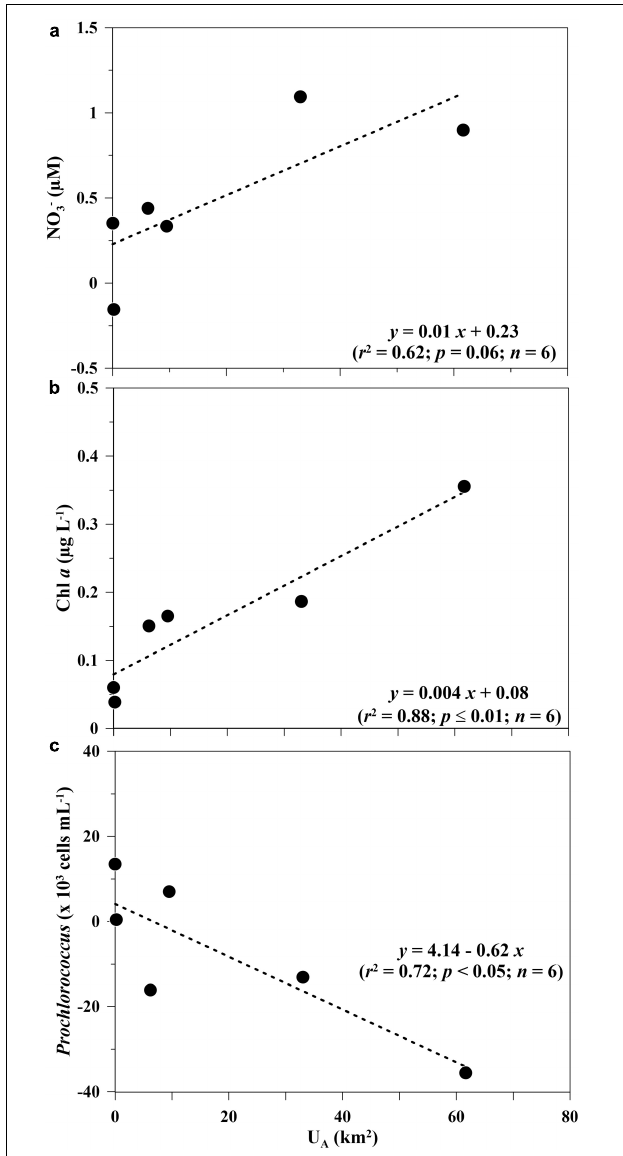
FIGURE 5 | Relationships between the uplift area ( U A ; km 2 ) versus: (a) nitrate concentration (NO 3 − ; µ M), (b) chlorophyll a value (Chl a ; µ g Chl L − 1 ), and (c) Prochlorococcus abundance ( × 10 3 cells mL − 1 ), and the values are the difference between the average depth-integrated nitrate concentration of onshore, Sts. (K101–104), and offshore, Sts. (K105–108) stations over each sampling period.